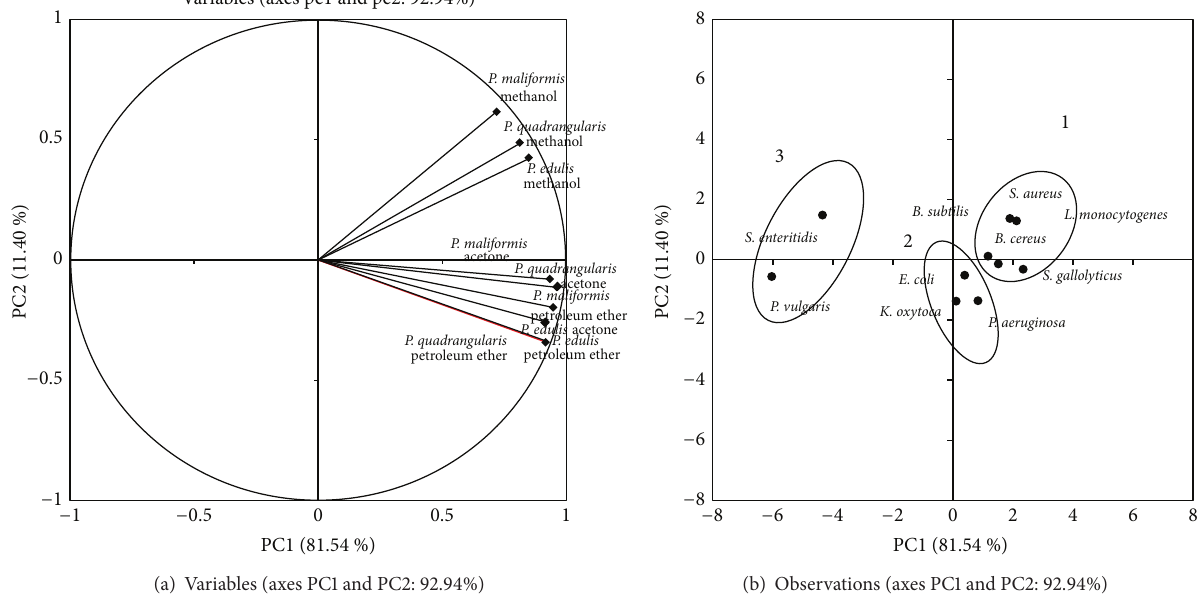
Figure 2: (a) Plot of the variables tested against pathogenic microbes for stems extracts. Percentages in parentheses represent the variation of each component. (b) Positions of the PC scores of the 10 microorganisms according to PC1 and PC2.